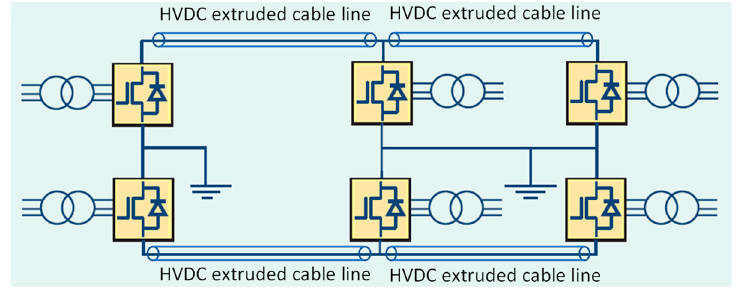
Figure 4. Multi-terminal VSC HVDC extruded cable transmission system configuration.